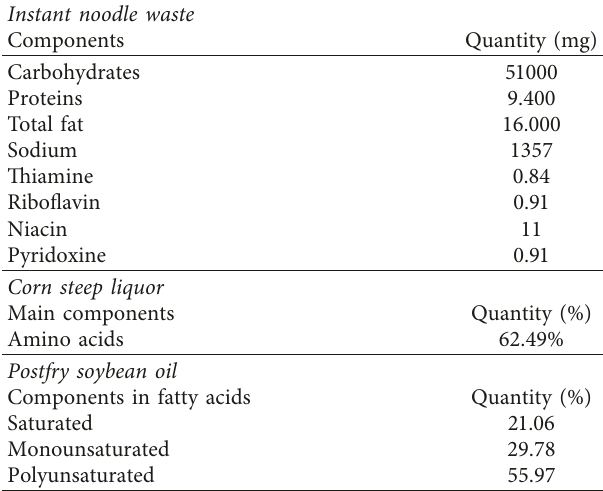
Table 1: Chemical compositions of renewable substrates instant noodle waste, corn steep liquor, and postfry soybean oil as com- ponents of the medium for biosurfactant production by C. echuinulata